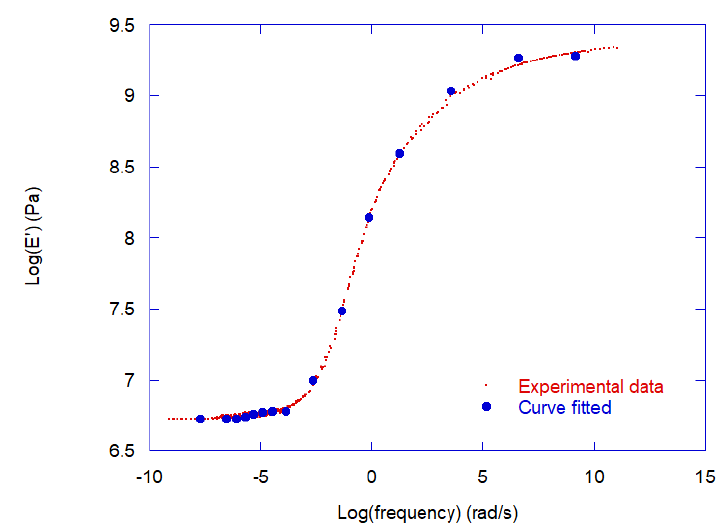
Figure 14. Master storage modulus of Polymer A.